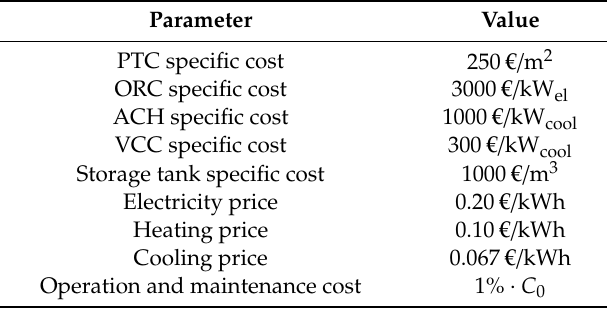
Table 4. Financial data of the present analysis